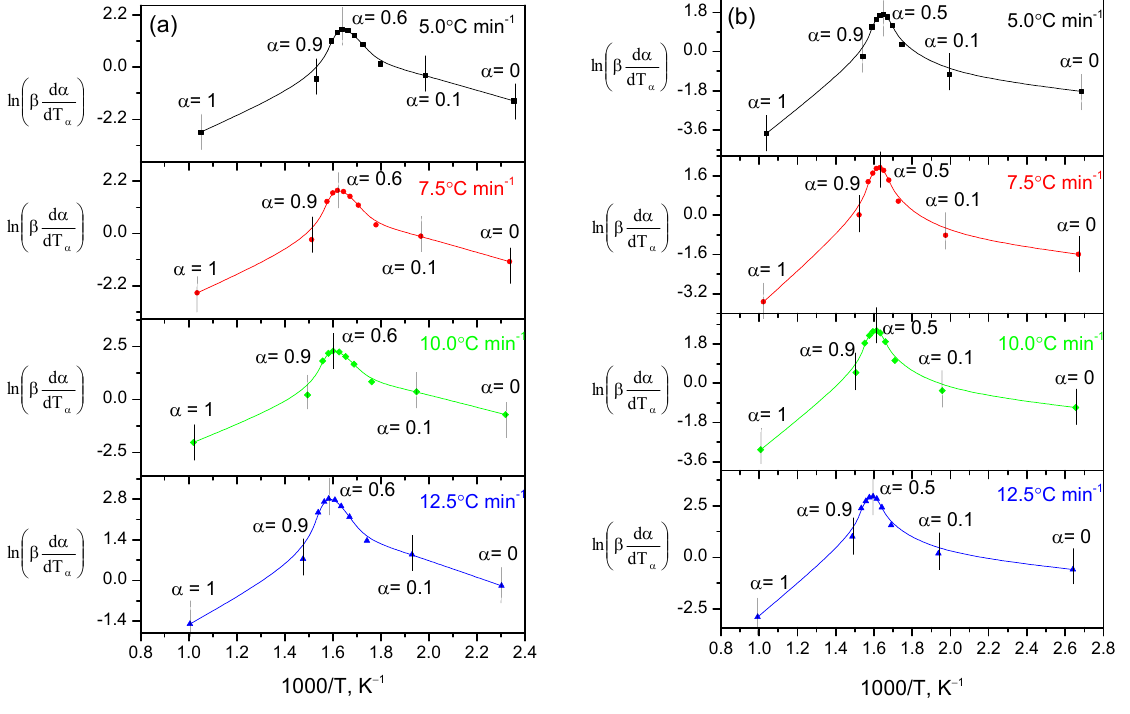
Figure 6. Ploing of Friedman method at selected four heating rates for ( a )−6.77:93.23 and Figure 6. Plotting of Friedman method at selected four heating rates for ( a )—6.77:93.23 and ( b )−86.67:13.33. ( b